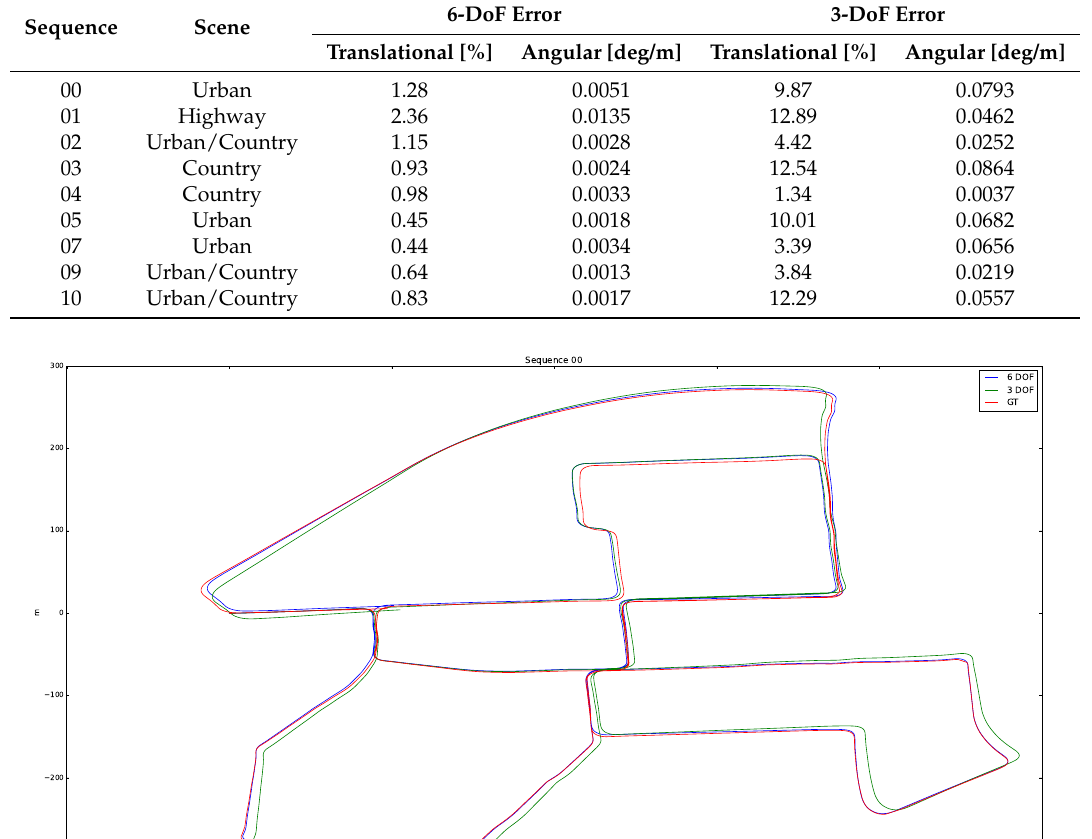
Table 2. Numerical results when processing the sequences with 6-DoF or 3-DoF.